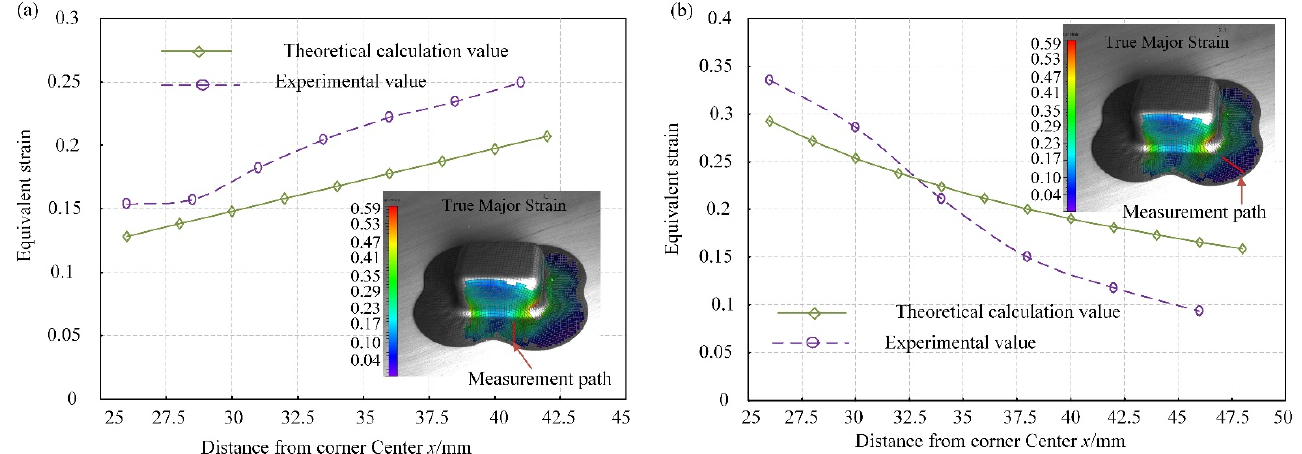
Figure 8. Equivalent strain distribution ( a ) in the straight-edge area; ( b ) in the corner area. The radial and tangential stresses at the measured path nodes in the straight-edge area of the FE model at the time of forming height 35 mm under the condition of 30 kN blank holder force were extracted and their distribution characteristics and theoretical calculation results are shown in Figure 9. The radial stress in straight-edge area is tensile stress, which gradually decreases from the inner edge to the outer edge, and the theoretical calculation results are quite close to the simulation results. The tangential stress is compressive stress; its absolute value increases gradually from the inner edge to the outer edge and the difference between the theoretical and simulated results of tangential stress at the outermost edge increases. In order to improve the applicability of the theoretical model to a variety of materials, the commonly used Hollomon hardening model is employed in this article, which belongs to a convex curve. As the strain increases, the gradient of stress increment becomes smaller, which produces an error with the real hardening law of some materials—the larger the strain, the greater the relative error produced. In addition, the inward concave profile near the midline of the straight-edge area makes the assumed linear variation law of equivalent strain in error with the actual one, resulting in a discrepancy between the theoretical calculation results and FE simulation results, with a maximum average discrepancy of 20.9%.